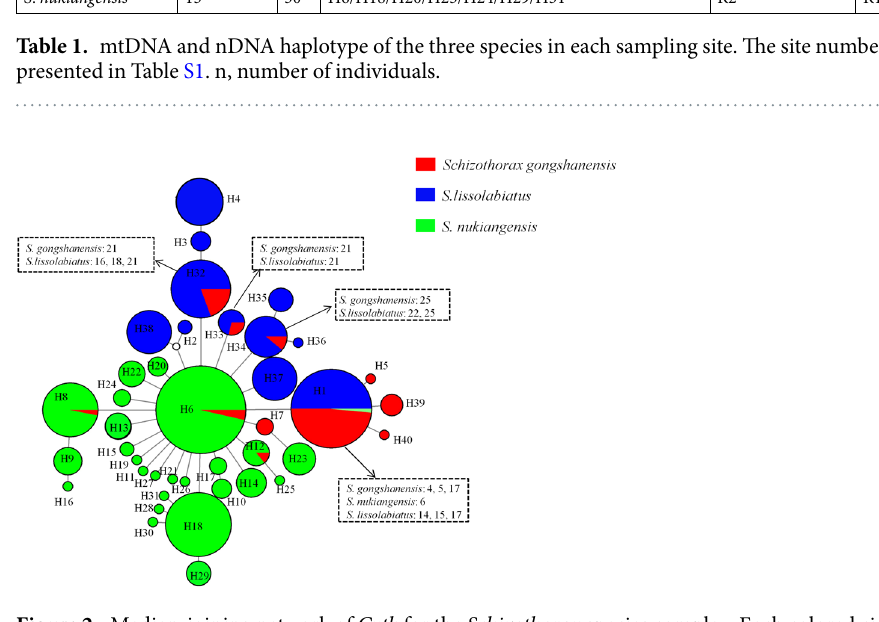
Figure 2. Median-joining network of Cytb for the Schizothorax species complex. Each colored circle represents different species, scaled according to its frequency in the entire sample. An empty circle indicates missing intermediate steps between observed haplotypes. The dotted rectangles indicate the populations of the three species with a shared Cytb haplotype. The location codes correspond to those in Table